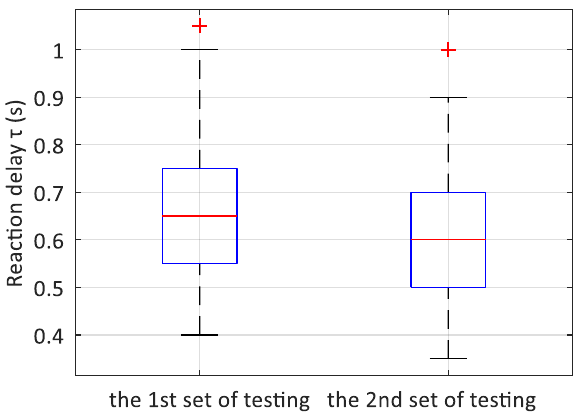
Figure 8. The box graphs for τ parameter.